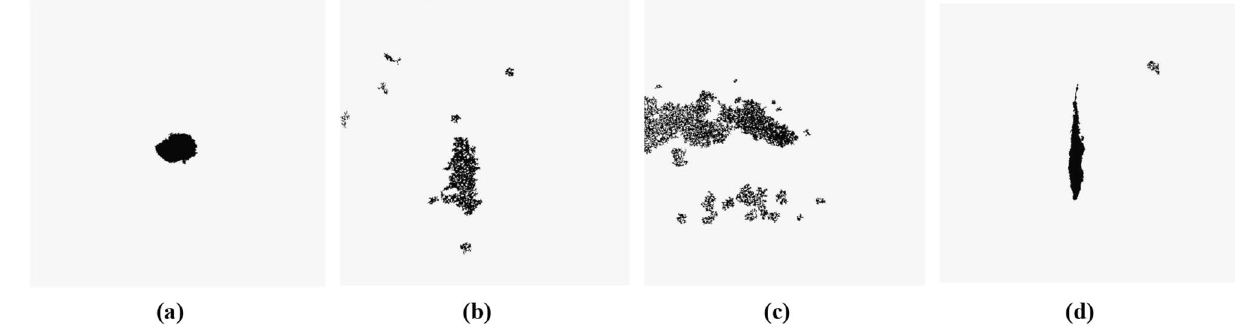
Figure 9. Water seepage feature images after removing small connected domains ( a ) point seepage; ( b ) surface seepage; ( c ) surface seepage; ( d ) line seepage.